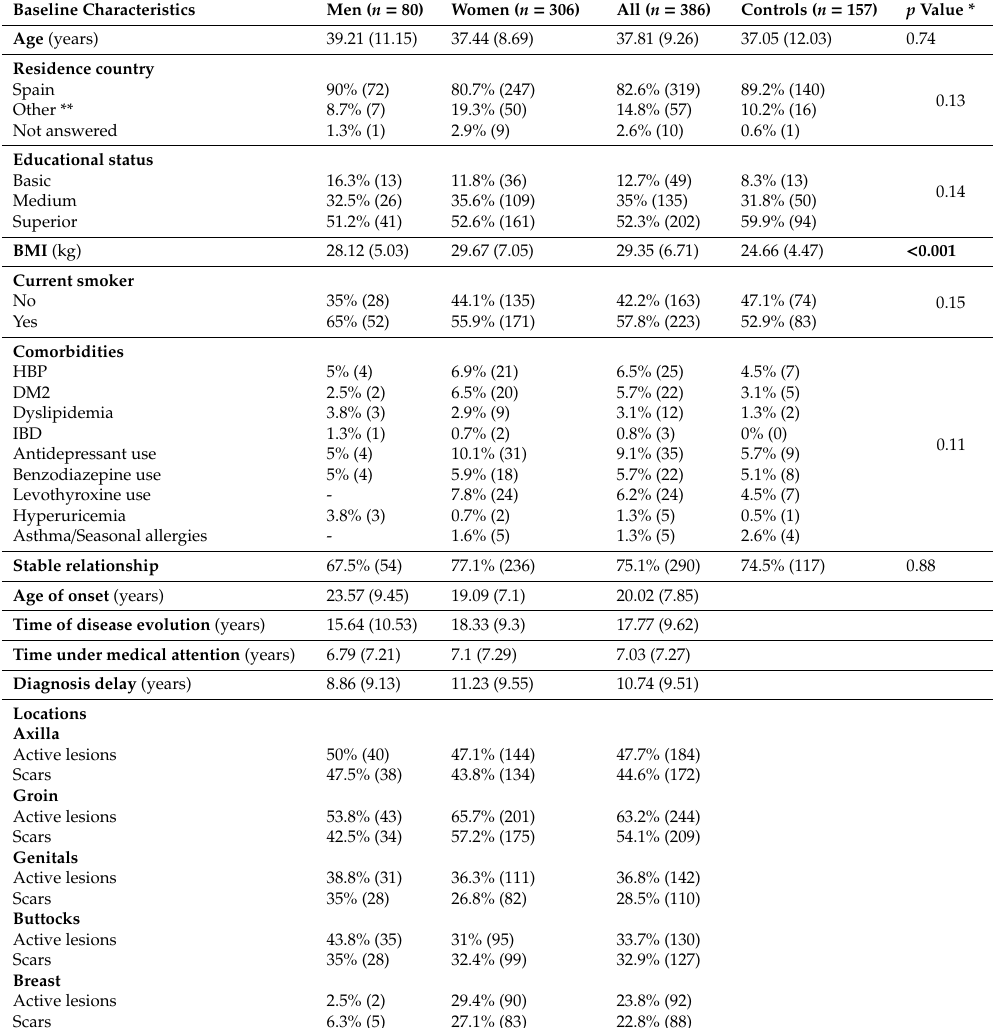
Table 1. Sociodemographic characteristics, comorbidities and baseline characteristics of patients with HS and healthy